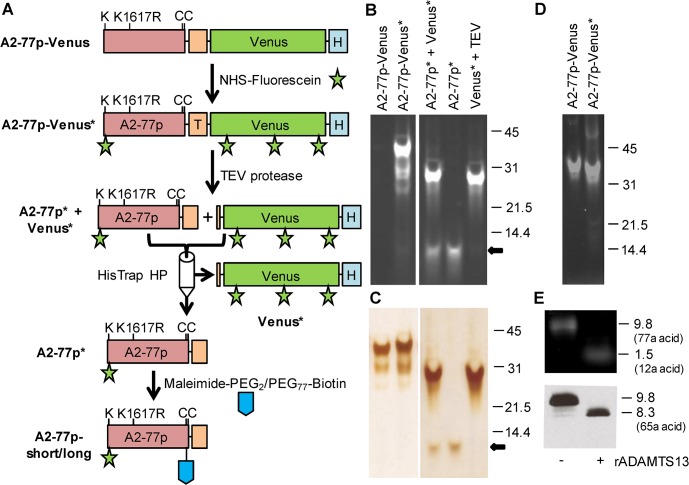
ADAMTS13 substrate synthesis.
A. The 37.3 kDa fusion protein A2-77p-Venus, purified from E. coli, was labeled with fluorescein yielding A2-77p-Venus*. A2-77p-Venus* incubated with TEV protease resulted in two fragments A2-77p* and Venus*, which were separated using a HisTrap HP column. A2-77p* was coupled with a biotinylation linker that had either 2 or 77 PEG spacer units. The final product that is coupled to both fluorescein and biotin is called A2-77p-short (2 PEG units) or A2-77p-long (77 PEG units). A similar protocol was applied to create negative control proteins where residues Y1606 and M1605 were replaced by alanine. T—TEV cleavage site, H—7x His tag. B. Starting material and intermediates resolved using a 4–20% gradient gel under reducing conditions. Fluorescence is due to fluorescein alone since Venus signal is lost upon boiling. C. Silver stain of gel in panel B. Peptide of interest (A2-77p*) appears at 9.8 kDa (arrow). D. A2-77p-Venus (unlabeled) and A2-77p-Venus* (fluorescein labeled) resolved using a 4–20% gradient gel under non-reducing conditions. Fluorescence in the gel is due to both Venus and fluorescein. E. A2-77p-short was incubated with or without 4.4U/ml rADAMTS13 for 90min. Product was resolved using a tricine gel. Top panel shows fluorescence under UV illumination. Bottom panel shows western blot of the gel using anti-biotin antibody. As expected, the 9.8 kDa substrate is cleaved into 1.5 kDa fluorescent (top gel) and 8.3 kDa biotinylated product (bottom gel).